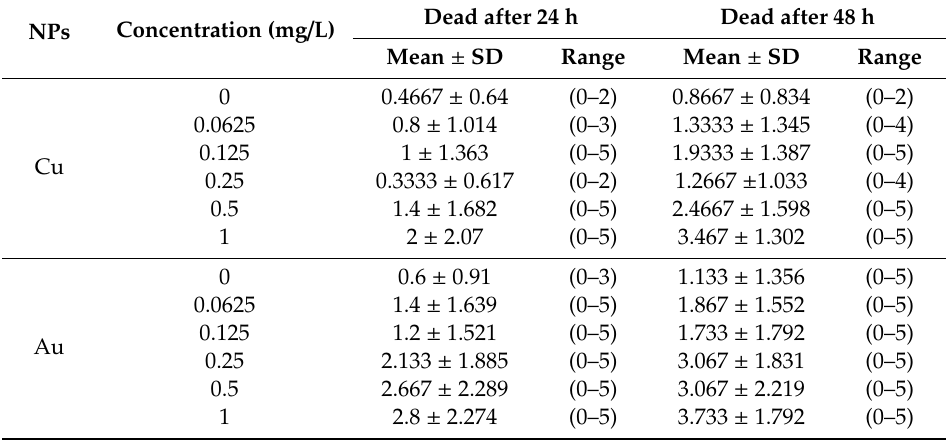
Table 1. E ff ects of di ff erent concentrations of NPs solution on survival of Daphnia pulex. NPs Concentration (mg /